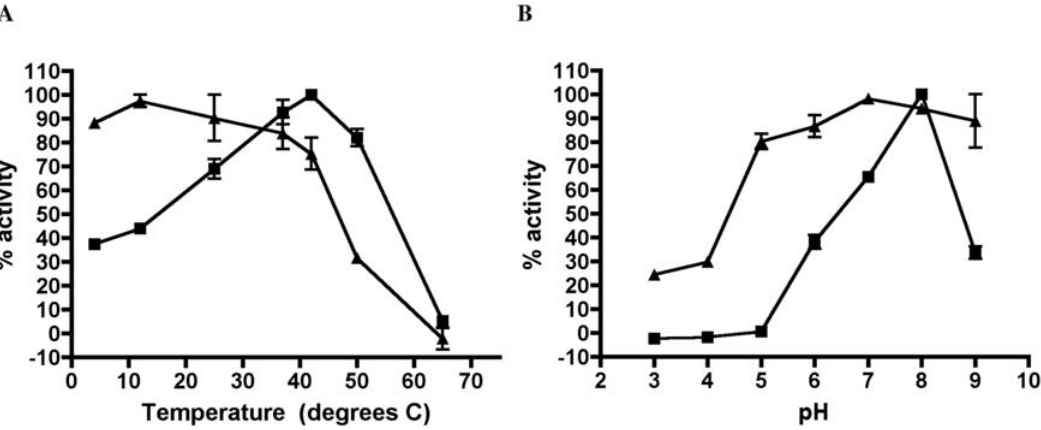
Figure 2. Activity and stability of purified recombinant HcDppIVA. A range of temperature (A) and pH (B) conditions were examined using substrate Gly-pro-AMC. To determine activity at different temperatures and pH, enzyme activity assays were performed at the indicated temperatures or pH values (squares). To determine stability, purified enzyme was incubated at the indicated condition for 30 minutes and subsequently assayed for remaining activity at pH 7, 37 u C (triangles). The values in conditions with the highest activity were set at 100%. Error bars represent the variability between two experiments. doi:10.1371/journal.pone.0005281.g002 14.3 mL and 17 mL indicating that substance P was cleaved (Figure 3). CD26 cleaves substance P after the proline in the second position from the amino-terminus, releasing Arg-Pro and then subsequently cleaves again releasing Lys-Pro [15,16]. We have not identified the substance P products after HcDppIVA or peak represents the product of the first cleavage event (SP 3-11),